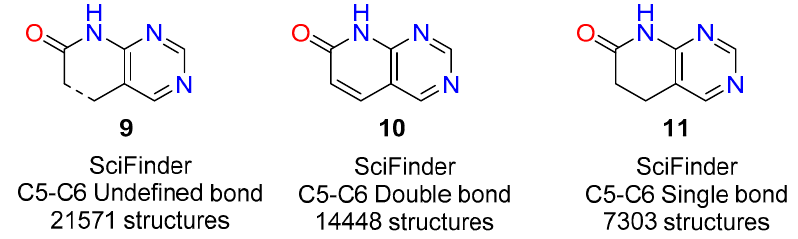
Figure 4. Number of pyrido[2,3- d ]pyrimidin-7(8 H )-ones ( 2 ) retrieved using an undefined bond ( 9 ), double bond ( 10 ) and single bond ( 11 ) between C5 and C6, respectively .